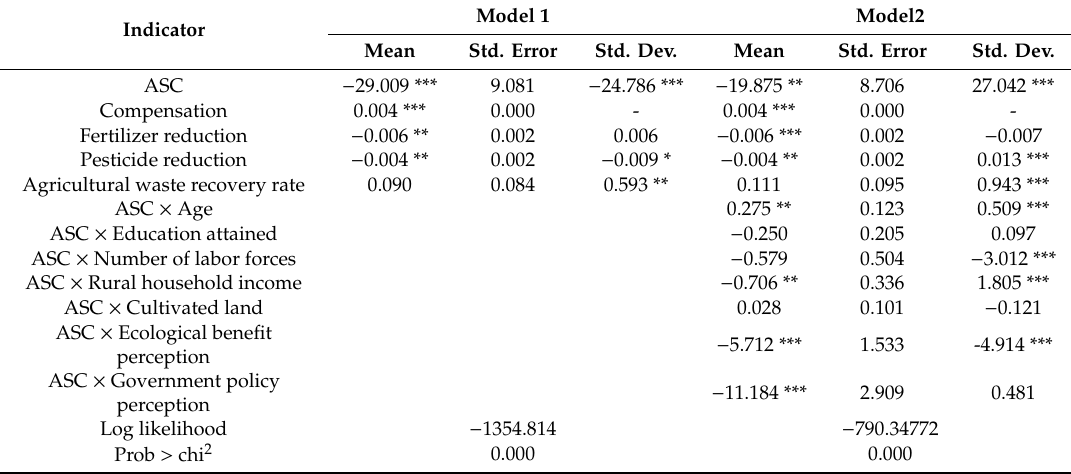
Table 4. Estimation result of RPL